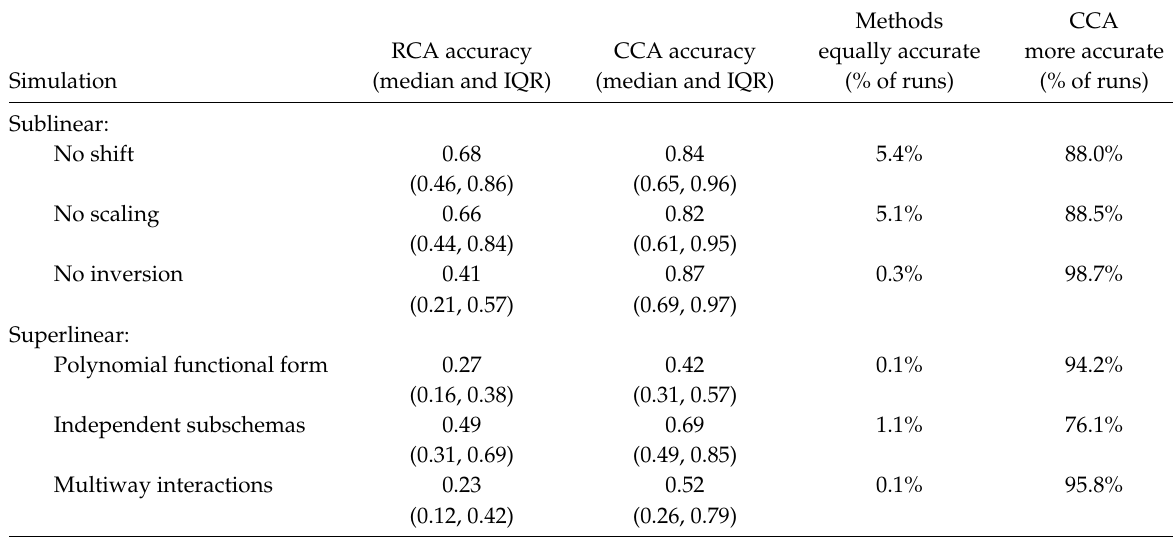
Table 2: Comparison of RCA and CCA accuracy in six sets of simulations with departures from theorized